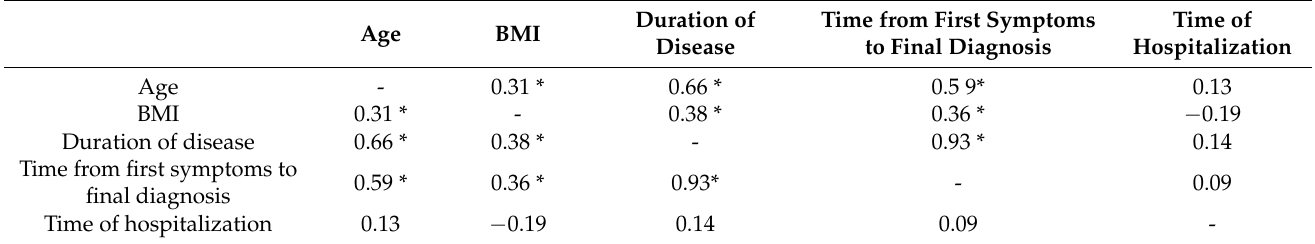
Table 2. Spearman’s rank correlation coefficients (r s ) between the analyzed